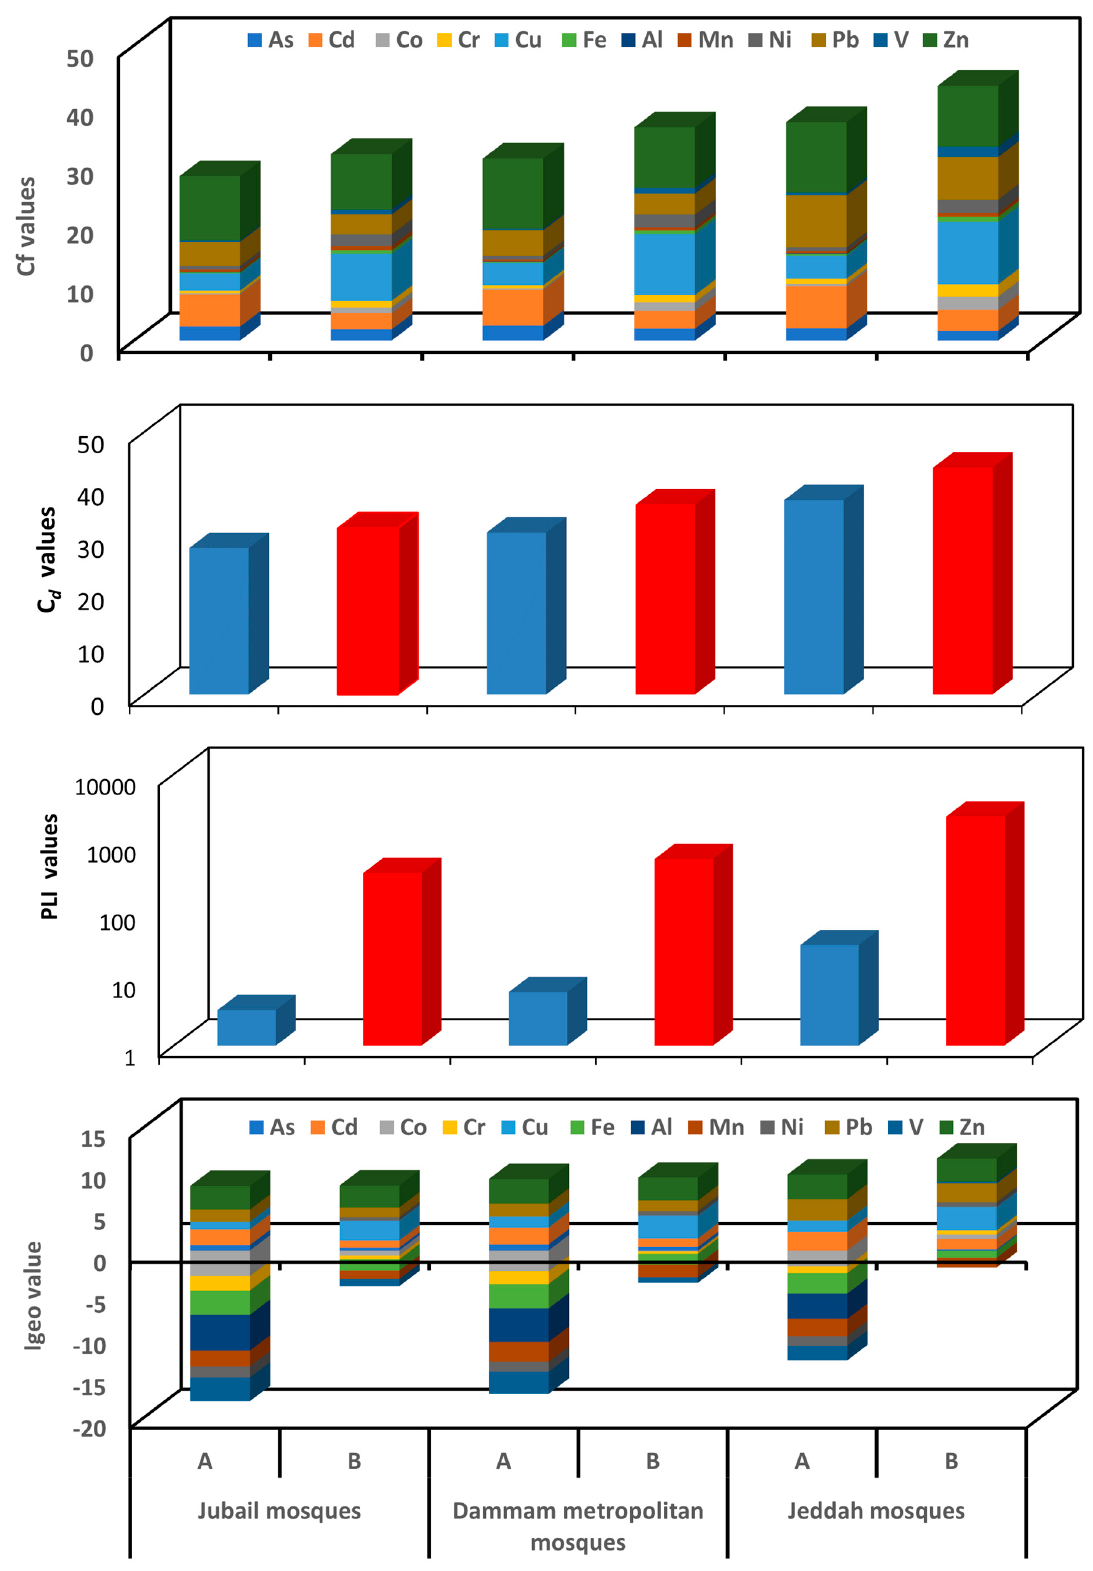
Figure 4. Contamination factor (C f ), degree of contamination (C d ), pollution load index ( PLI ), and geo-accumulation index (I geo ) of PHEs in ACFD of Jubail, Dammam metropolitan, and Jeddah mosques: Based on the global crustal data (A) and local background soil data (B).